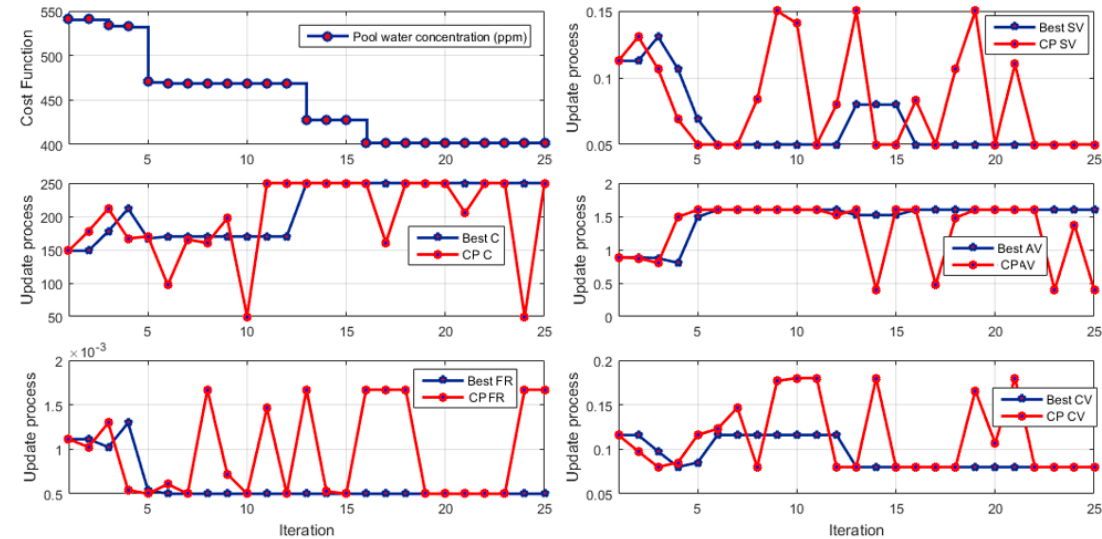
Figure 7. The cost function variation, best values of decision variables during the optimization process of pool water concentration. C is the capacitance, CP is the center point, FR is the flow rate, SV is the spacer volume, AV is the applied voltage, and CV is the cell volume.